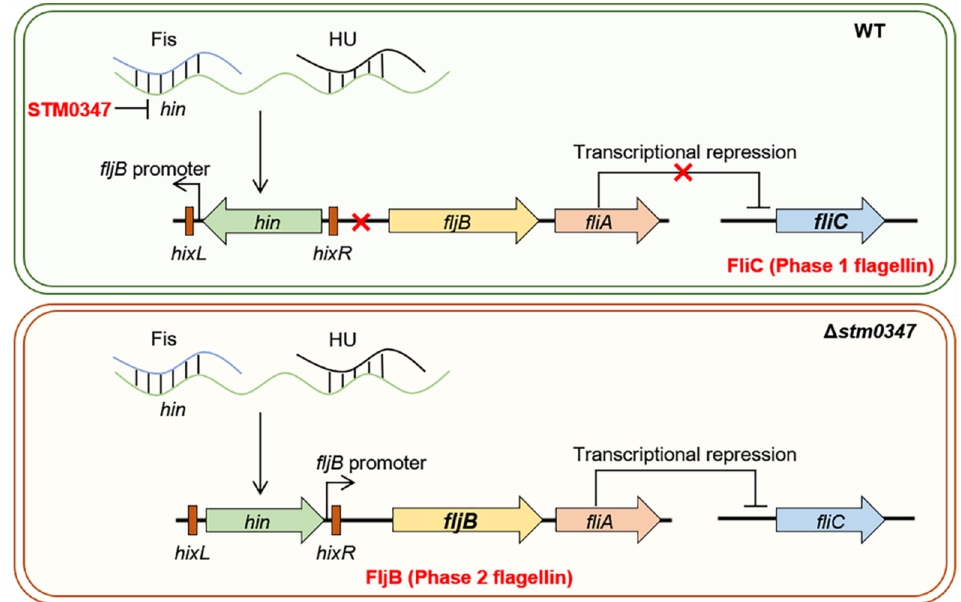
Figure 8. A proposed regulatory pathway of STM0347 mediated flagellin phase variation. STM0347 disrupted the Hin-catalyzed DNA strand exchange through attenuation of hin levels, and further inhibited the expression of flagellin transforming from FliC to FljB.